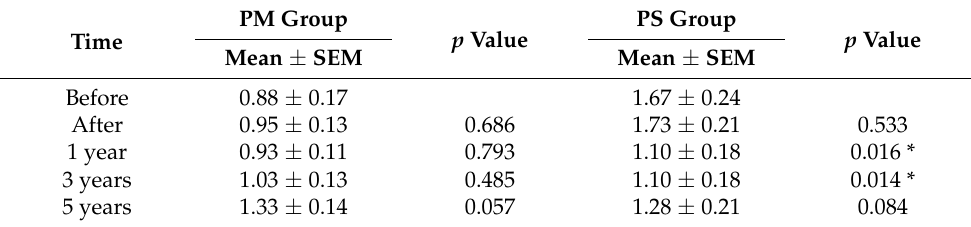
Table 2. The mean vMBL outcomes.